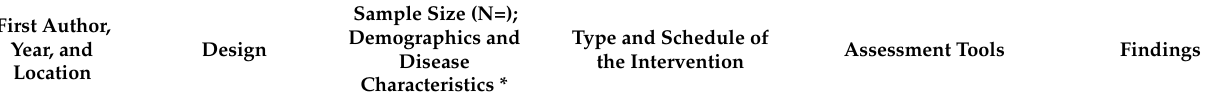
Table 2. An overview of the interventional